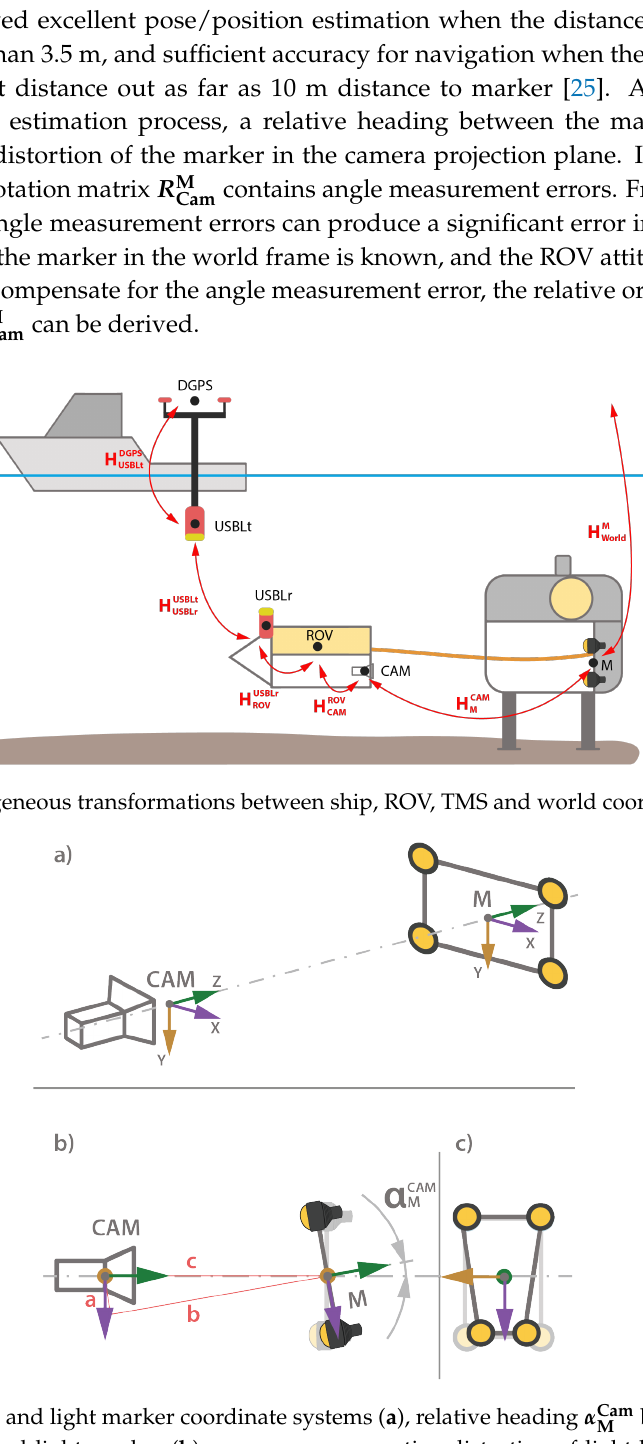
between the image M